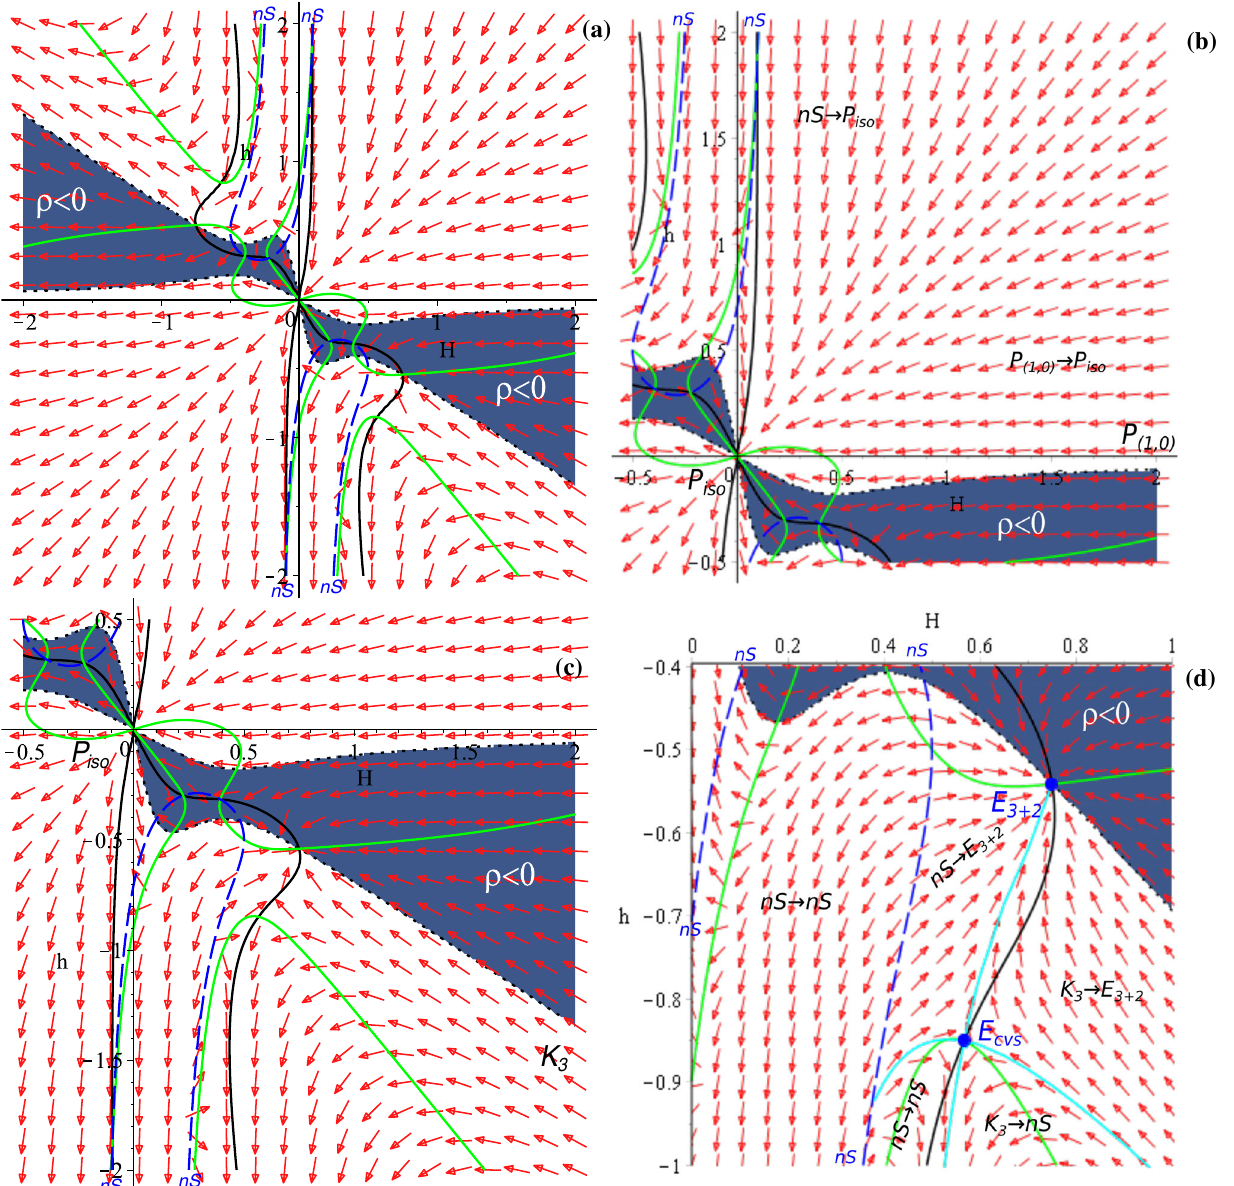
Fig. 5 Phase portraits for D = 2 α > 0, 1 / 3 > ω > 0 case: general view on a , focus on h > 0 regimes on b , focus on h < 0 regimes on c and focus on the regimes in the vicinity of E 3 + 2 solution on d . Light blue line separate initial conditions leading to different regimes. Dark